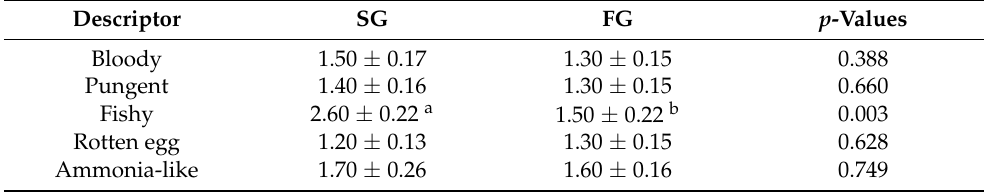
Table 3. Comparison on descriptive sensory intensity from slow- and fast-growing duck